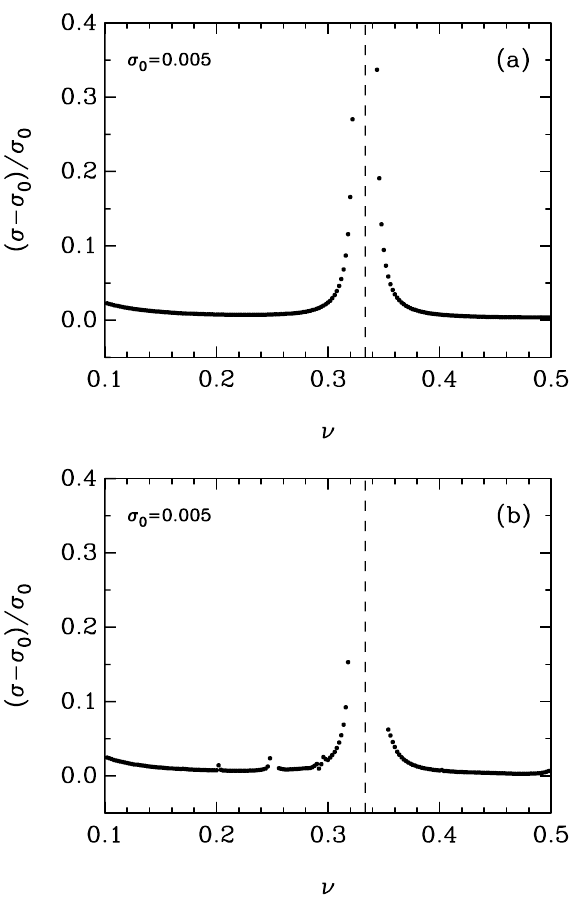
FIG. 5. The relative increase of the asymptotic equilibrium value of the rms emittance s as a function of n calculated by (a) using the moment map (69) and (b) the direct tracking of the phase-space grid points for the Hénon map. The initial rms emittance s (cid:48) (cid:173) (cid:53) 3 (cid:49)(cid:48) 2 (cid:51) . The dashed line indicates n (cid:173) (cid:49)